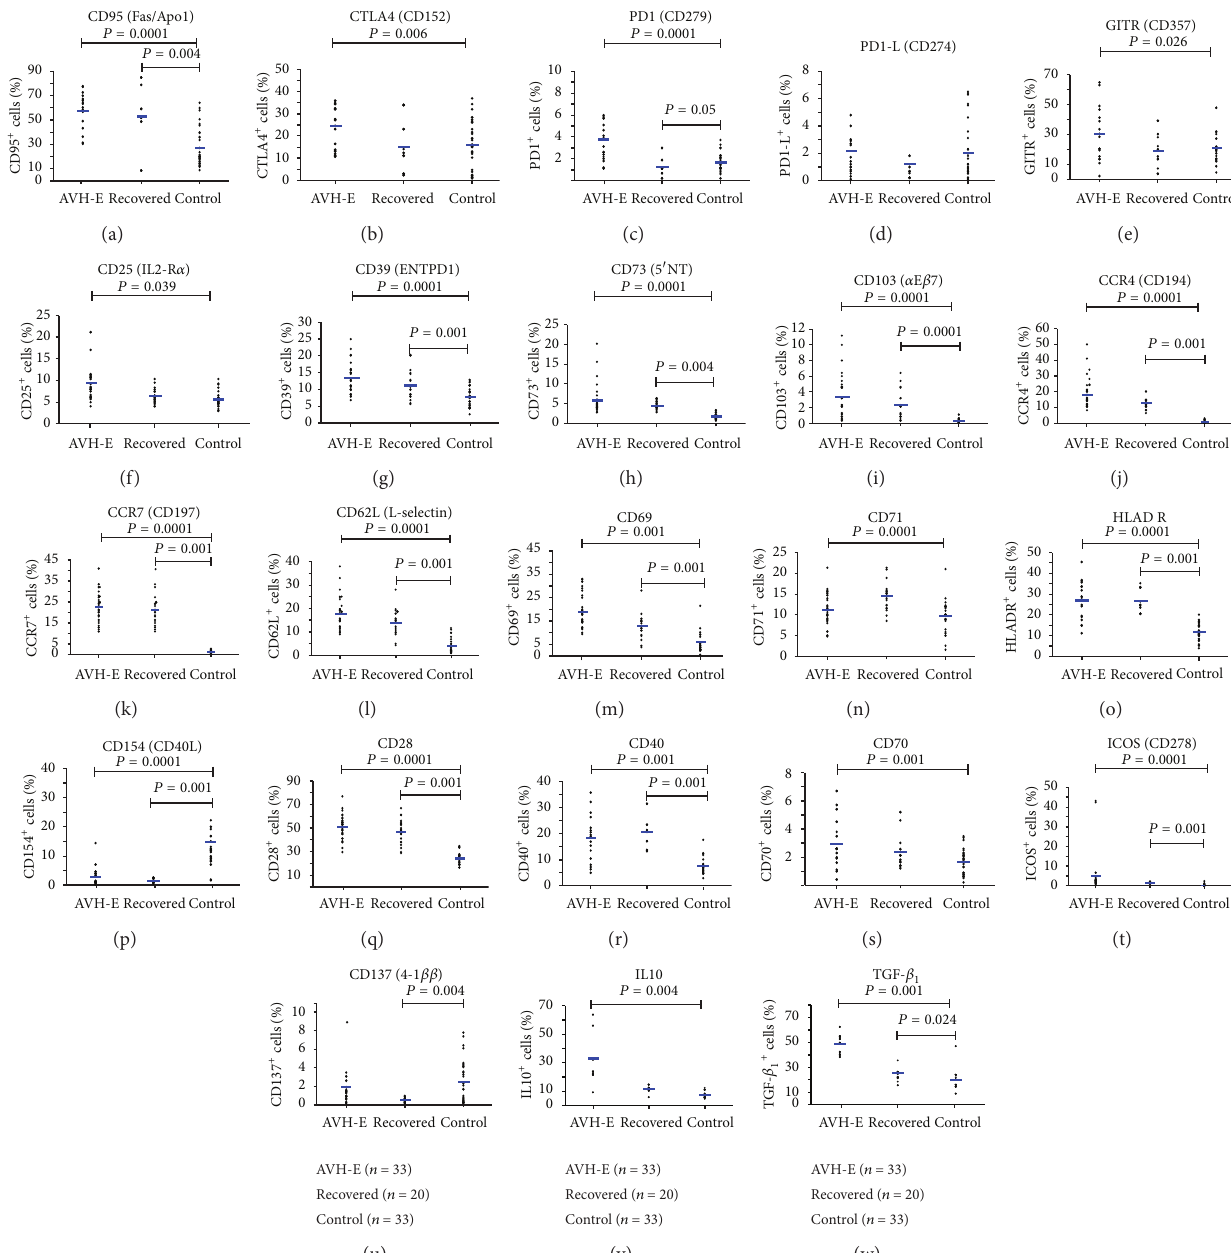
Figure 1: Peripheral expression profiles on the unstimulated PBMCs of hepatitis E patients by flow cytometry. Unstimulated PBMCs from controls, AVH-E, and recovered individual groups were stained with antibodies against different phenotype markers, apoptotic/inhibitory (a–f), ectonucleotidase (h-g), integrin (i), chemokine and selectin (j–l), activation (m–o), costimulatory (p–u), and Treg-associated cytokines (v-w). An isotype-matched antibody was used as a negative control. Each dot represents an individual data point and the horizontal lines represent the mean. The ANOVA with Bonferroni post hoc corrections was used to compare differences among groups. Data are representative of mean ±